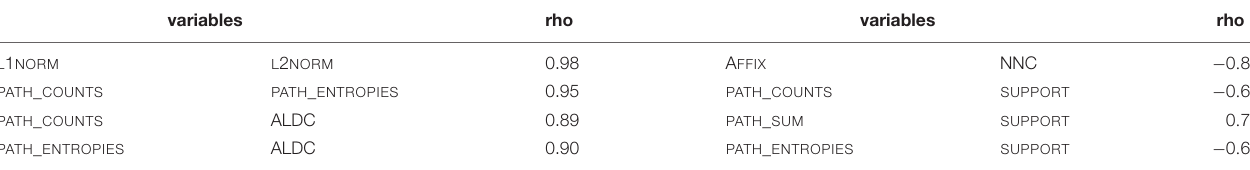
TABLE 2 | Correlated variables and their correlation coefficients.